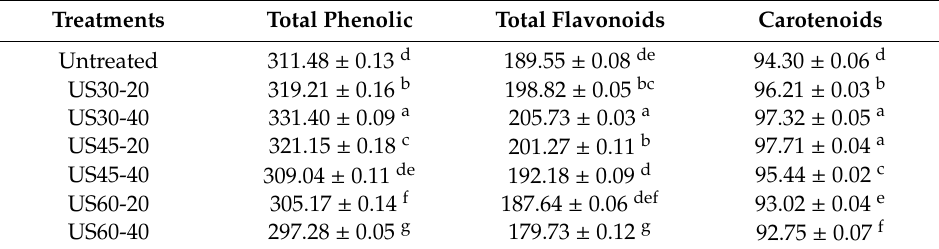
Table 3. Impact of TU treatment on bioactive